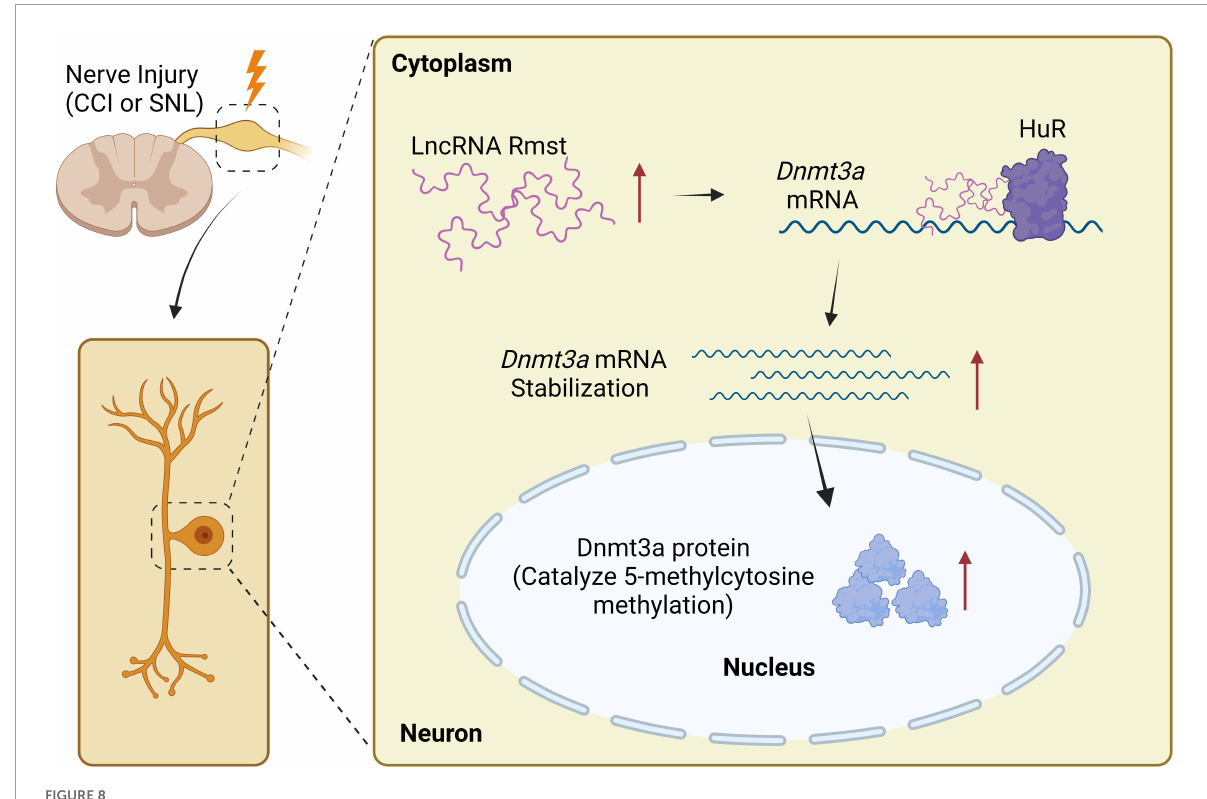
FIGURE8 Proposed mechanism on rhabdomyosarcoma 2-associated transcript ( Rmst ) in NP. Nerve injury-triggered Rmst upregulation interacts with HuR in injured DRGs, resulting in stabilizing Dnmt3a mRNA and protein. The latter one has been reported as a critical NP regulator in DRG neurons. In contrast, in normal DRG neuron, Dnmt3a mRNA would be degraded without Rmst